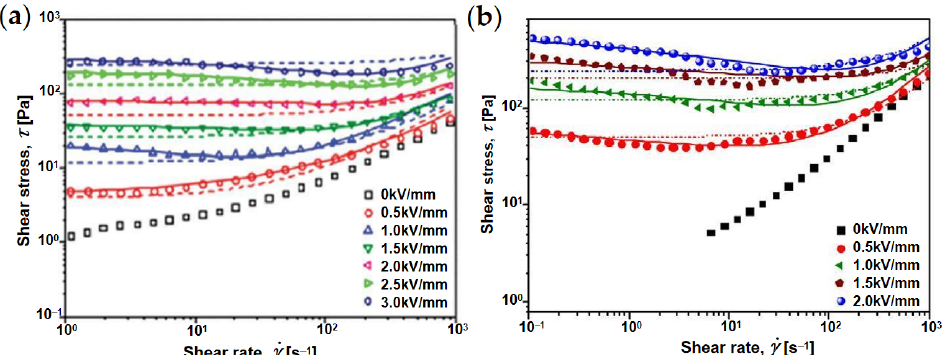
Figure 11. Flow curve of shear stress–shear rate of ER fluids of GO/SiO 2 under DC electric field ( a ) and under 1000 Hz of AC electric field ( b ); Flow curve of shear stress–shear rate of ER fluids of rGO/SiO 2 under DC electric field ( c ) and under 1000 Hz of AC electric field ( d ) [68].